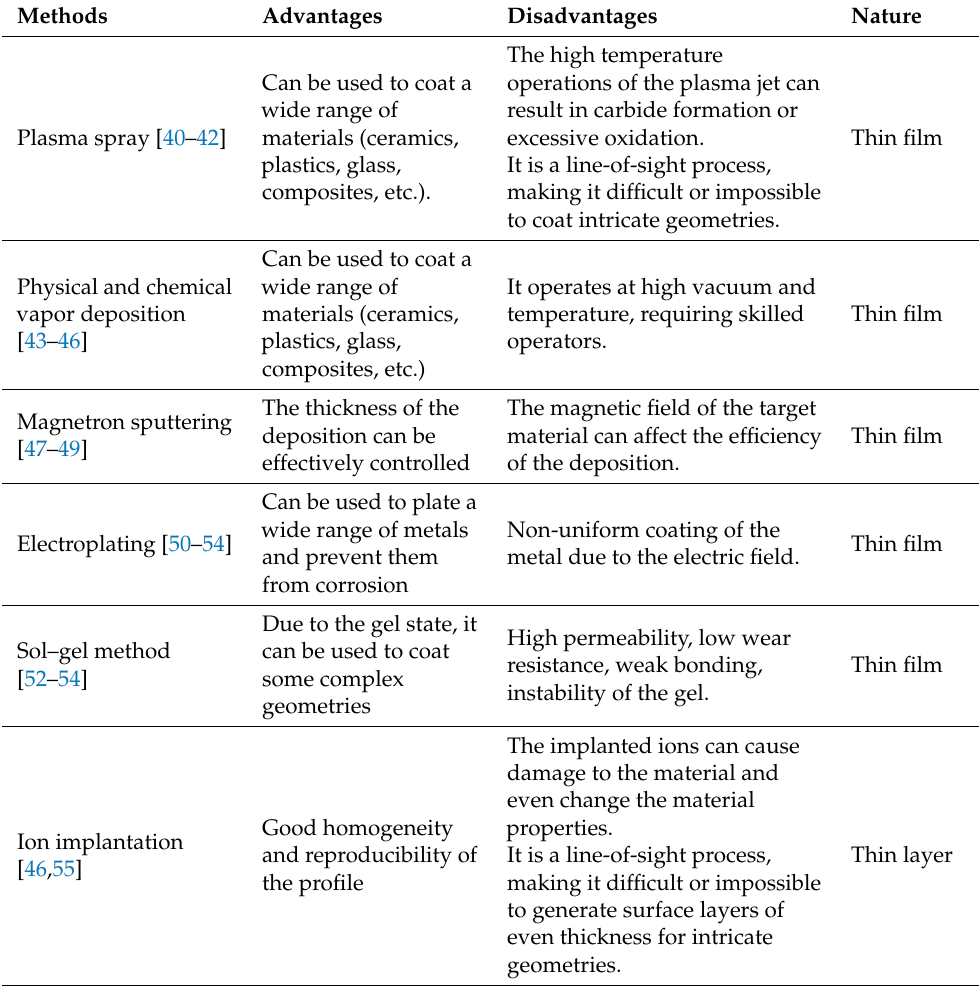
Table 1. Methods used for coating biomedical